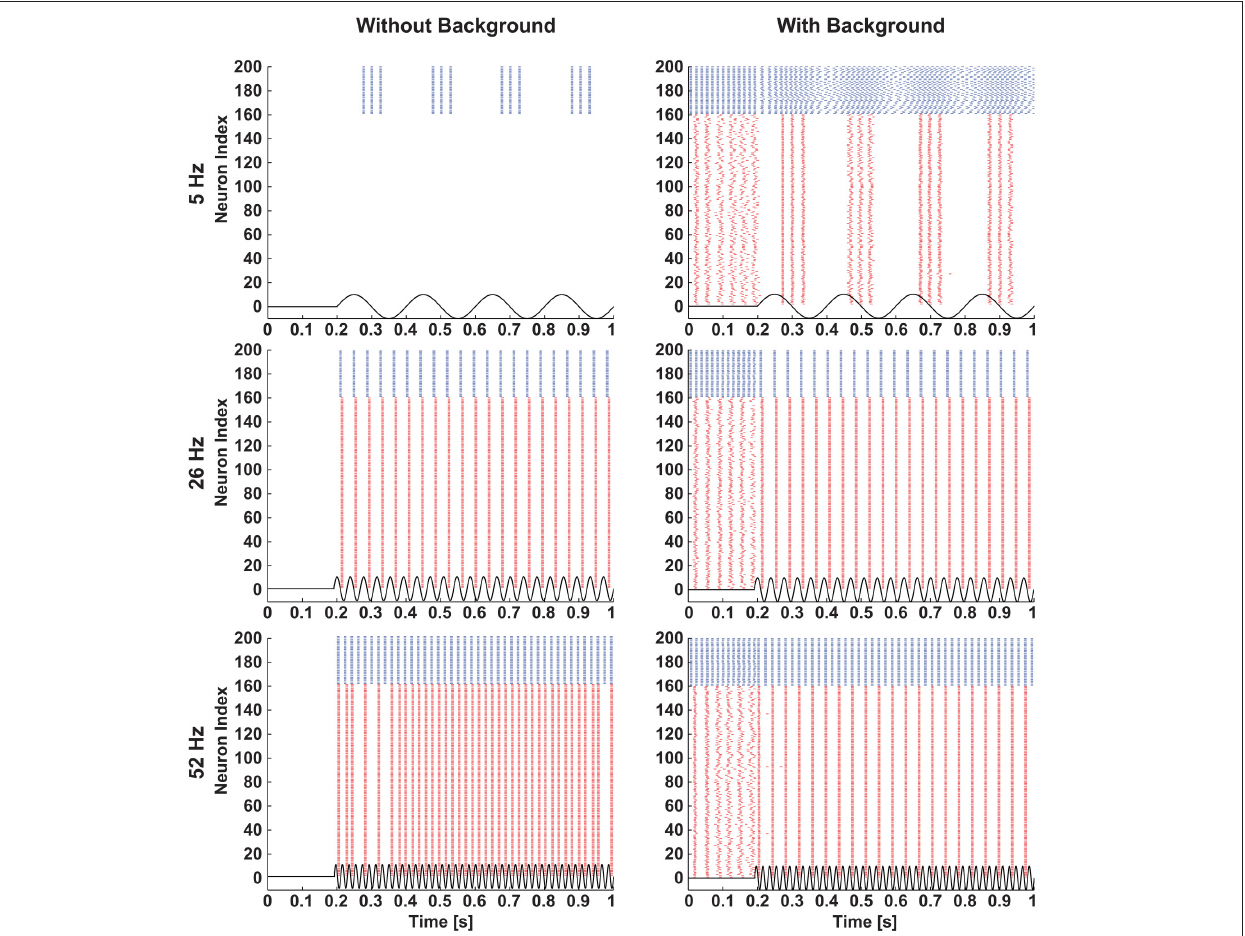
FIGURE 6 | Selective modulation of excitatory and inhibitory neurons in a network. A small-world network of excitatory and inhibitory neurons was stimulated with three different frequencies of sinusoids ( 5 Hz: top row, 26 Hz: middle row, and 52 Hz: bottom row) of 38 mV amplitude when the network was silent (left column) and activated by background excitatory synaptic inputs (right column). Raster plots of the network illustrate that when stimulated with sinusoids, the silent network showed similar firing patterns as in single neurons (see Figure 2 ), and the spontaneously active network showed selective modulation of excitatory and inhibitory neurons. The blue and red colors represent activities of inhibitory and excitatory neurons, respectively.